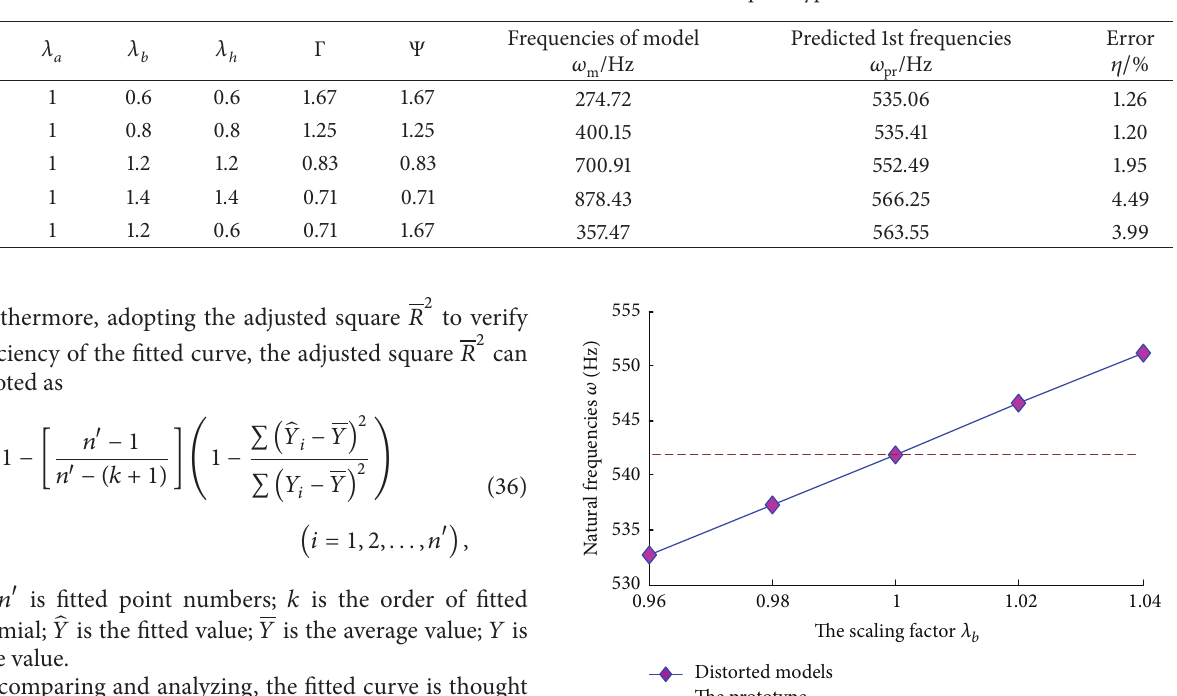
Table 6: The errors between the distorted models and prototype.